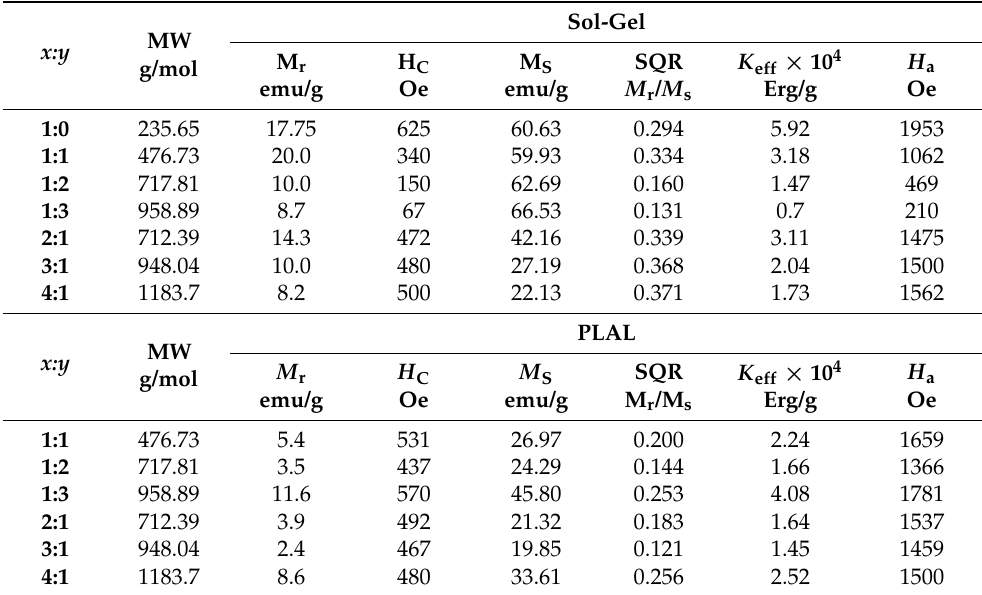
Figure 7. M vs. 1/ H 2 plots for (Co 0.5 Ni 0.5 Ga 0.01 Gd 0.01 Fe 1.98 O 4 ) x /(ZnFe 2 O 4 ) y NCs synthesized by ( a ) sol-gel method and ( b ) PLAL method, 300 K. Table 2. Room temperature magnetic parameters (Co 0.5 Ni 0.5 Ga 0.01 Gd 0.01 Fe 1.98 O 4 ) x /(ZnFe 2 O 4 ) y NCs synthesized by both sol-gel and